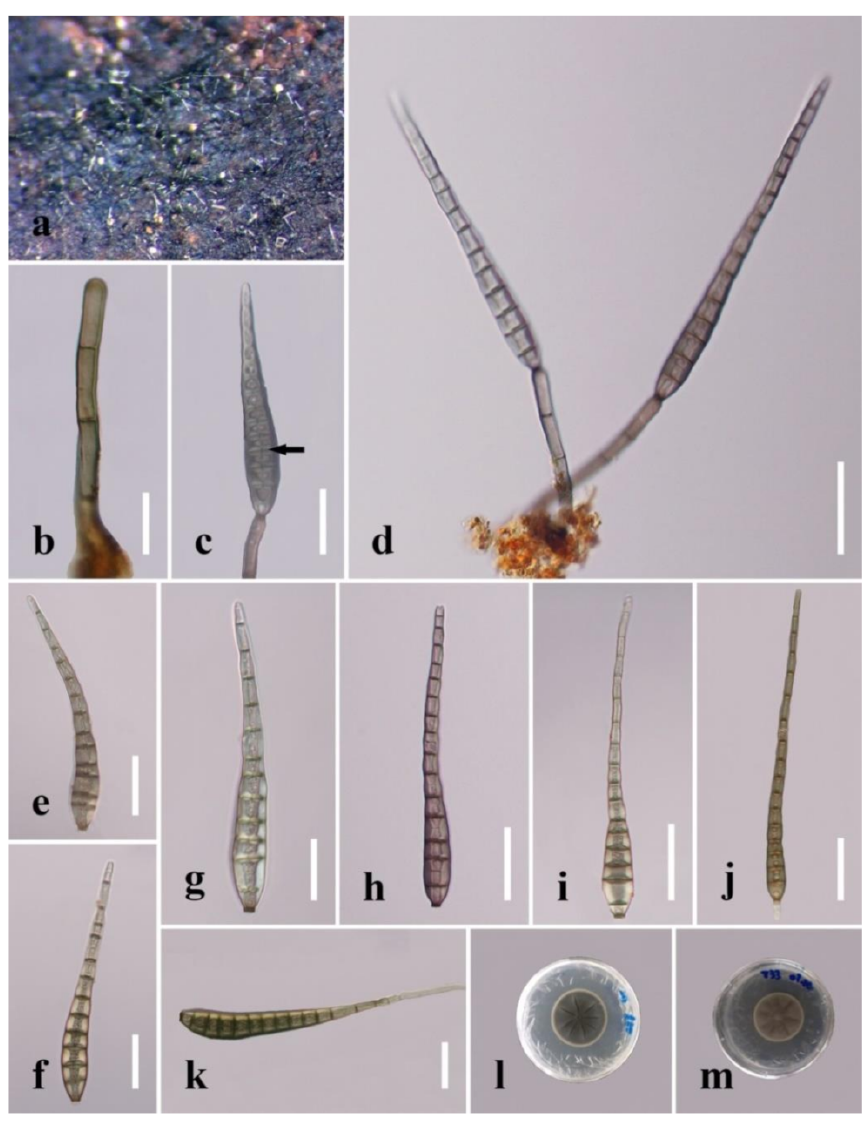
Figure 14. Distoseptispora rayongensis . ( a ) Colonies on natural substrate. ( b ) Conidiophore. ( c ) Coni- diogenous cell with conidium. The arrow in c points to a gap in the middle of the septum, which indicates the distosepta. ( d ) Conidiophores with conidia. ( e – j ) Conidia. ( k ) Germinated conidium. ( l ) Colony on PDA (from front). ( m ) Colony on PDA (from reverse). Scale bars: ( b ) 20 µ m; ( c , e – k ) 30 µ m; ( d ) 40 µ